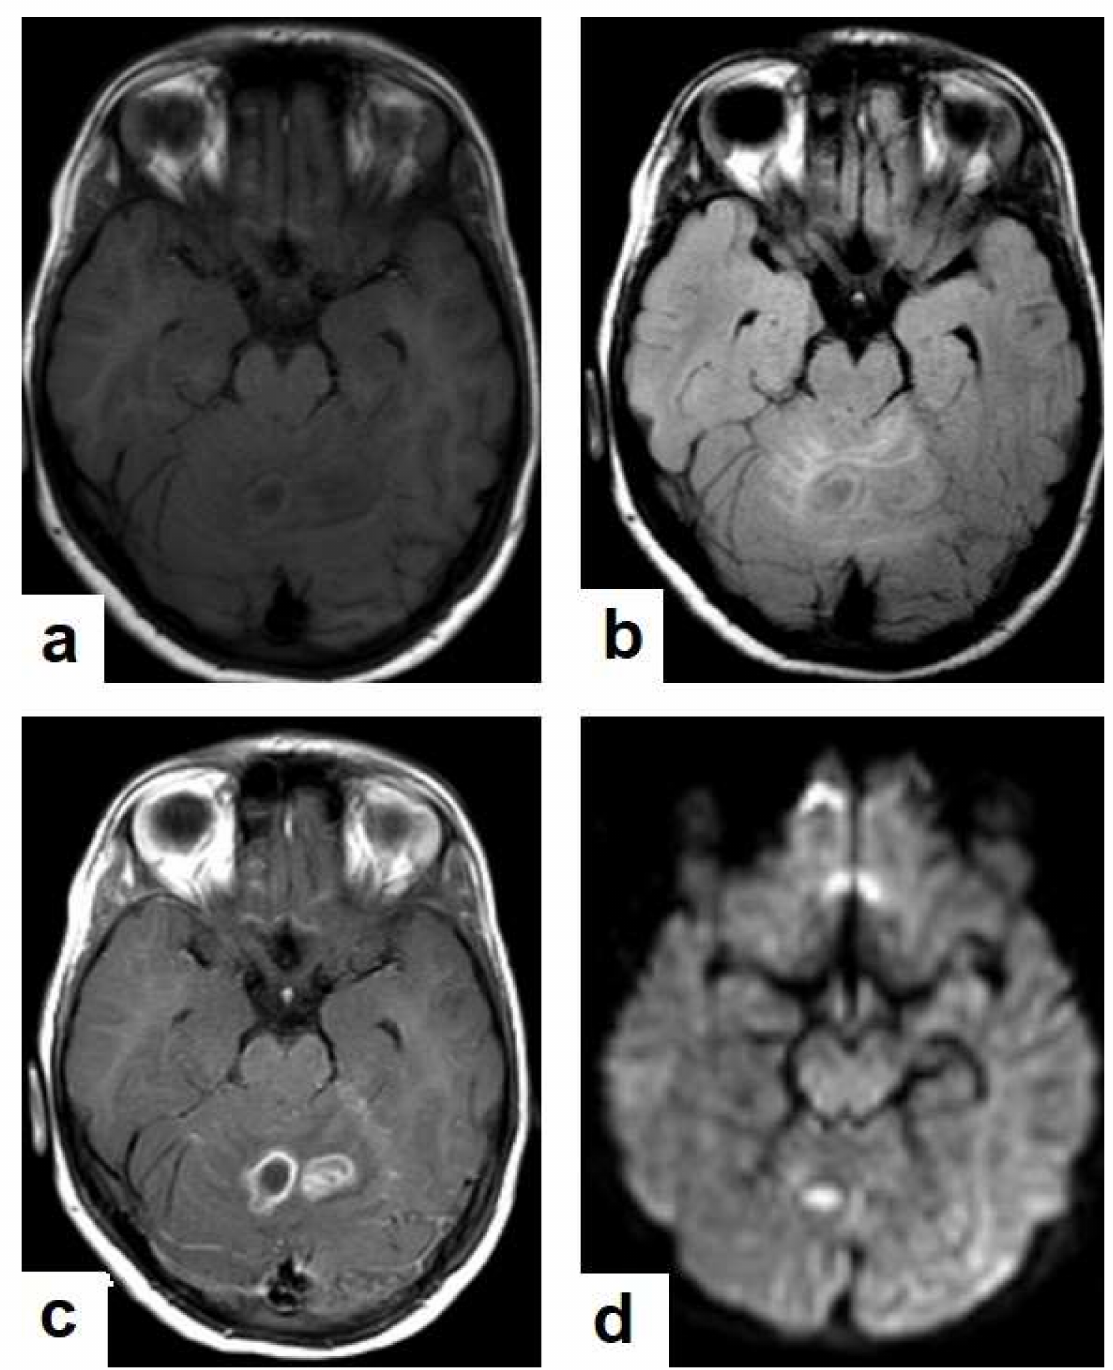
Figure 17. A tuberculous abscess in the cerebellum of a 13-year-old female (same patient as Figure 16). Selected images of brain MRI ( a ) T1-weighted image (WI), ( b ) FLAIR-WIs, ( c ) T1-WI with contrast, and ( d ) diffusion-weighted (DW) image. The images show a well-defined lesion in the cerebellum with low signal intensity content and a high signal intensity capsule on T1WI and FLAIR ( b ), marginal enhancement on T1WI with contrast administration ( c ), and restricted diffusion on DWI ( d